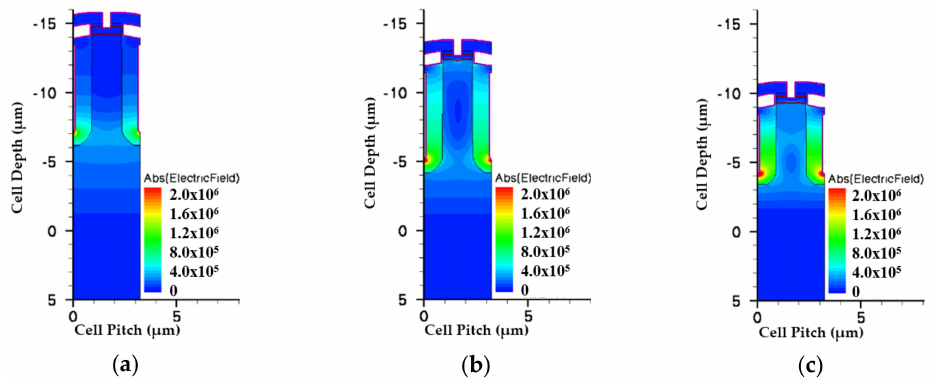
Figure 9. The simulated electric fields for the split-gate trench power MOSFET with ( a ) single EPI, ( b ) double EPIs, and ( c ) triple EPIs at 150 V rating voltage. The color bars are scaled on the same